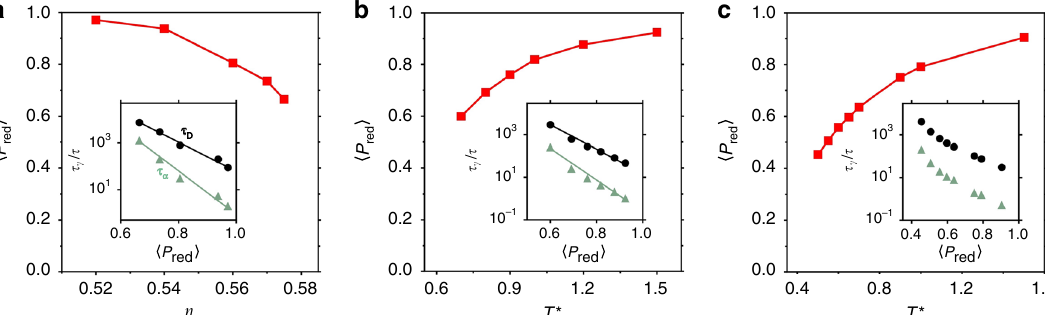
Fig. 4 Structural order parameter as a function of supercooling. Mean membership probability < P red > for the three systems: a as a function of the packing fraction η for hard spheres, and as a function of the reduced temperature T * for b Wahnström and c Kob – Andersen. The insets show the relation between < P red > and either the structural relaxation time τ α (green triangles) or the diffusion time τ D (black circles). In all cases, P red is calculated using the UML approach trained at the highest degree of